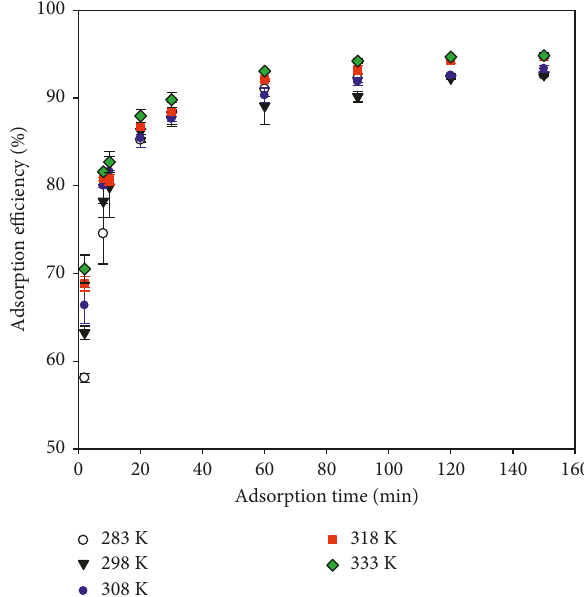
Figure 6: Effect of temperature on the adsorption efficiency of MB.